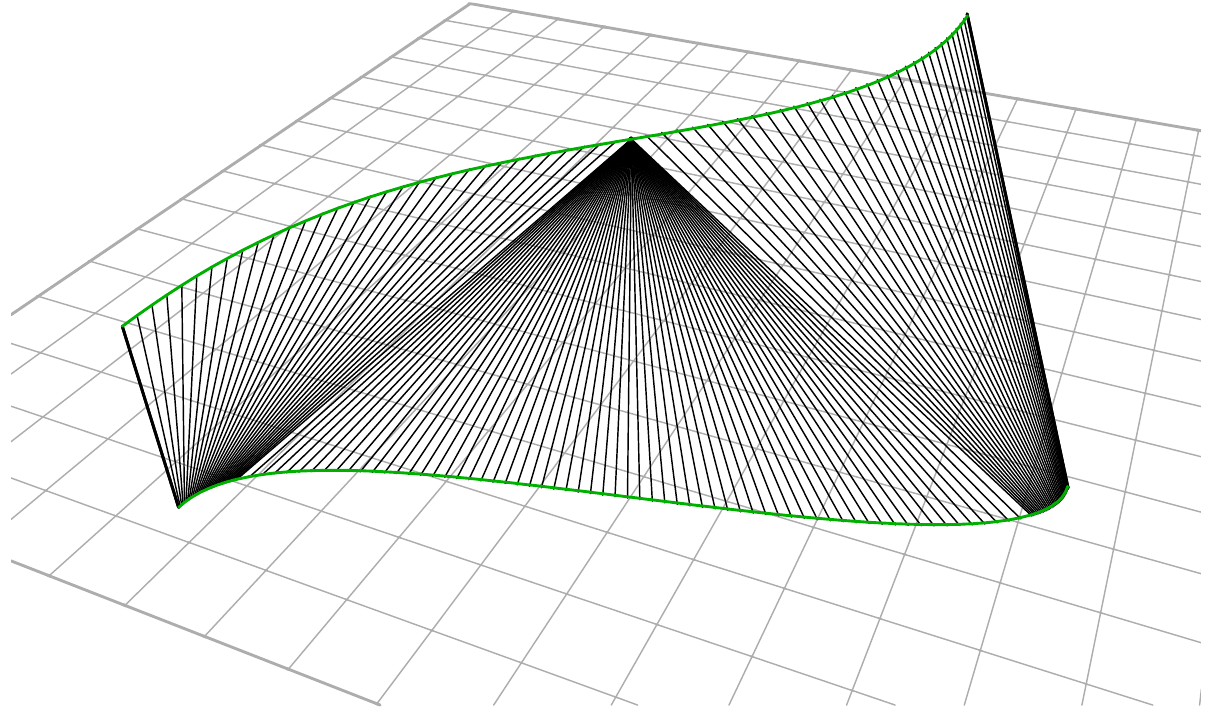
Figure 2. Attempting to create a developable surface from two ‘S’ shaped splines above, this surface can only be made developable by introducing the radial singularity shown at the